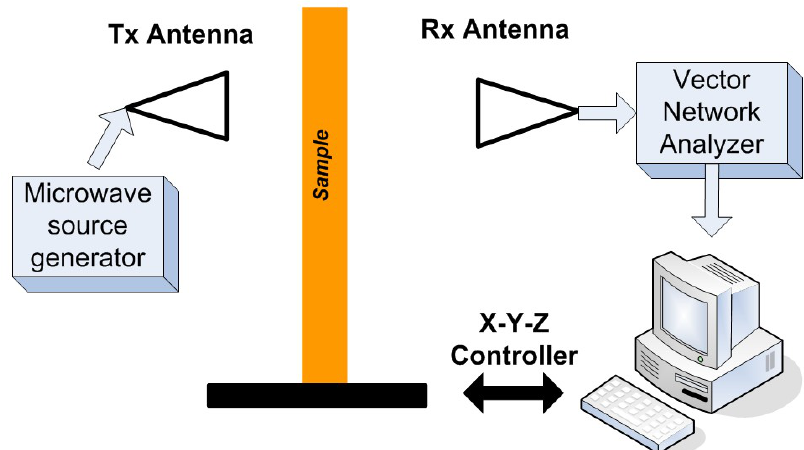
Figure 29. A typical microwave imaging system